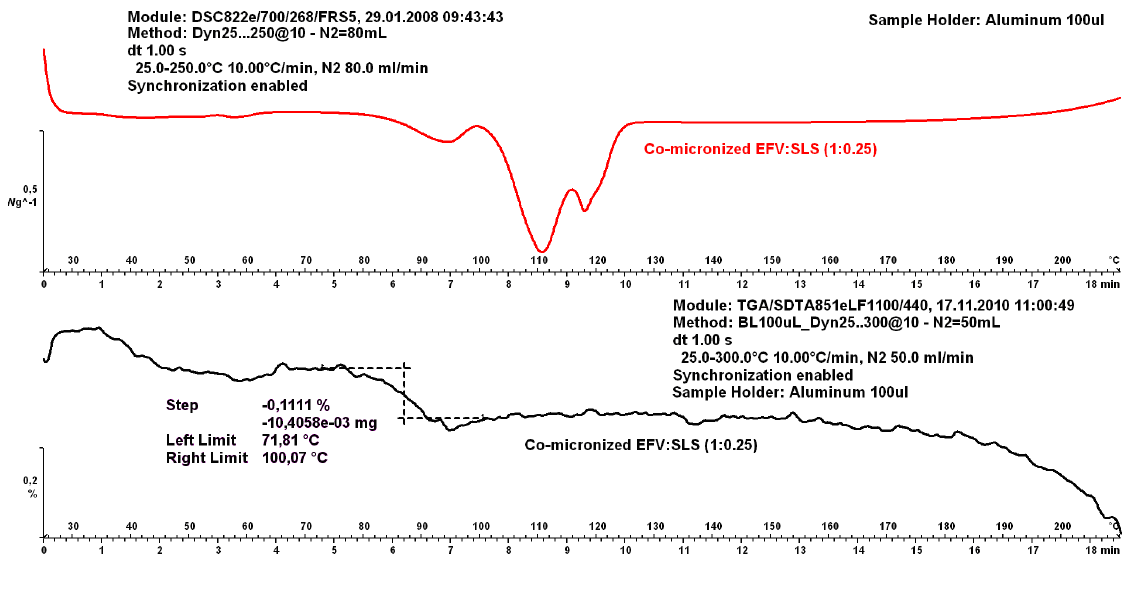
Figure 9. Thermogravimetric analysis (TGA) curves of co-micronized mixture EFV:SLS proportion (1:0.25) compared to DSC curve.